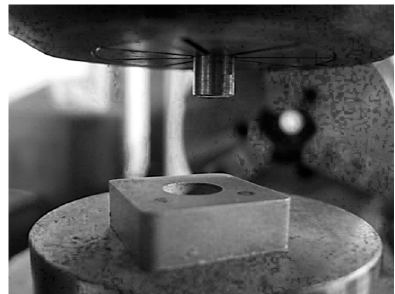
Figure 5. The device.